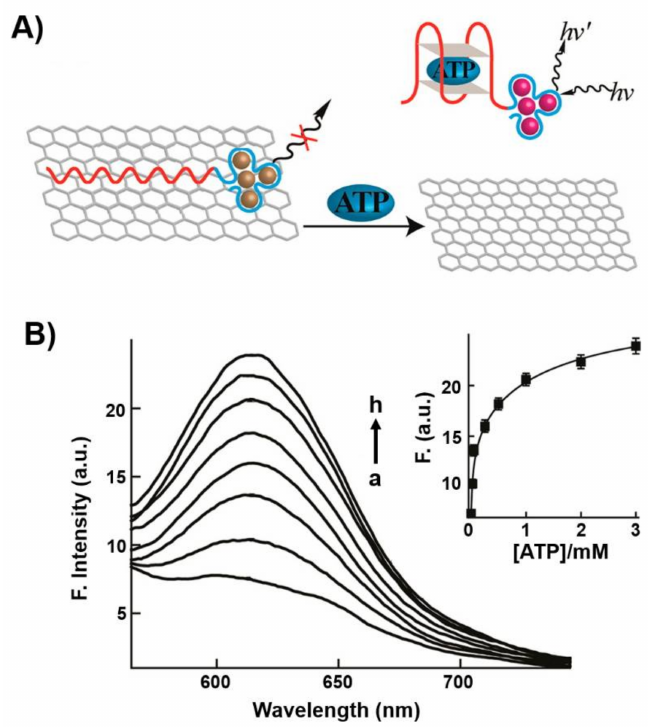
Figure 2. ( A ) Application of graphene oxide modified with ATP aptamer conjugated to nucleic acid- stabilized silver nanoclusters (AgNCs) as a hybrid system for the analysis of ATP. The fluorescence of the AgNCs is quenched in the aptamer/graphene oxide hybrid structure and it is switched on upon the desorption of the AgNCs-ATP aptamer/ATP complex from the graphene oxide support. ( B ) Fluorescence spectra generated upon desorption of the AgNCs-ATP aptamer/ATP complex in the presence of different concentrations of ATP for a fixed time-interval of 1 h. a = 0 mM; b = 0.025 mM; c = 0.05 mM; d = 0.25 mM; e = 0.5 mM; f = 1 mM; g = 2 mM; h = 3 mM. Inset: derived calibration curve. Reproduced with permission from ref. [91]. Copyright 2013 American Chemical Society. Arrows: the arrows correspond to typical excitation and emission